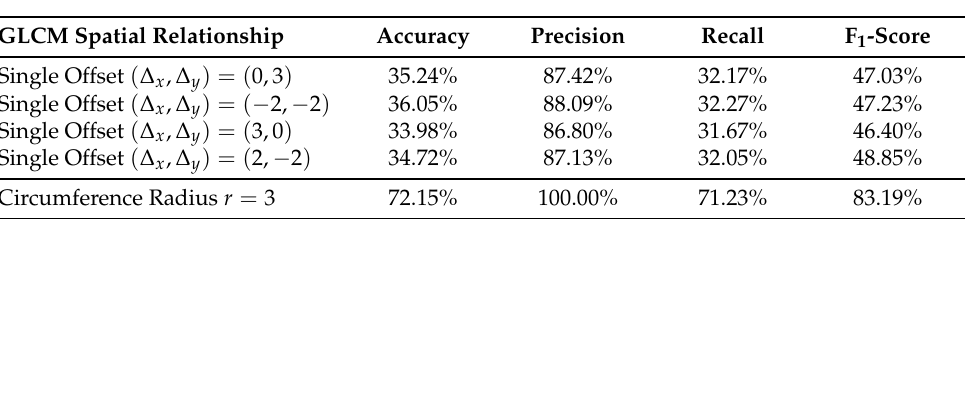
Table 3. Performance evaluation on the UMCD dataset comparing classical Haralick textural features with single displacement to the proposed discretized